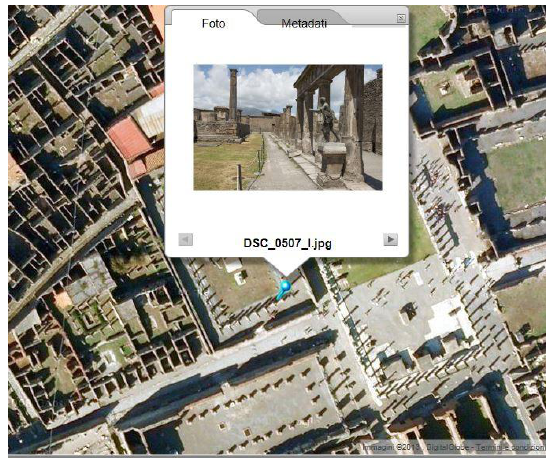
Figure 1. Apollo’s Temple image on Nikon Image